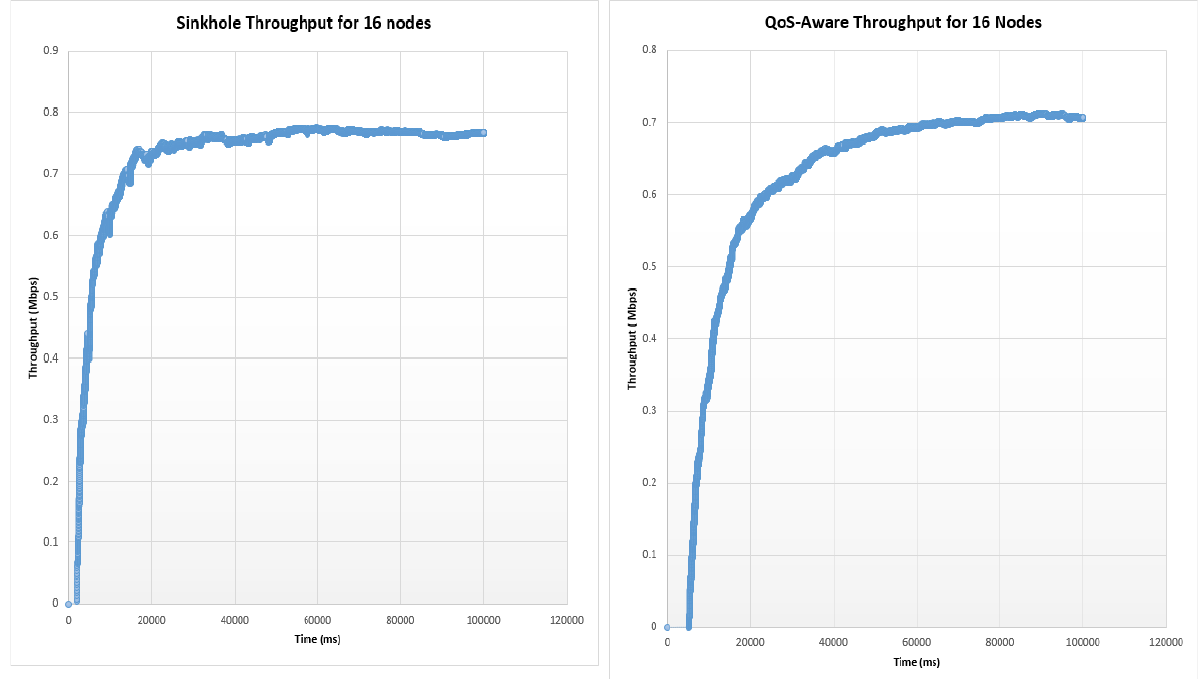
Figure 10. Throughput for sinkhole and framework scenarios.